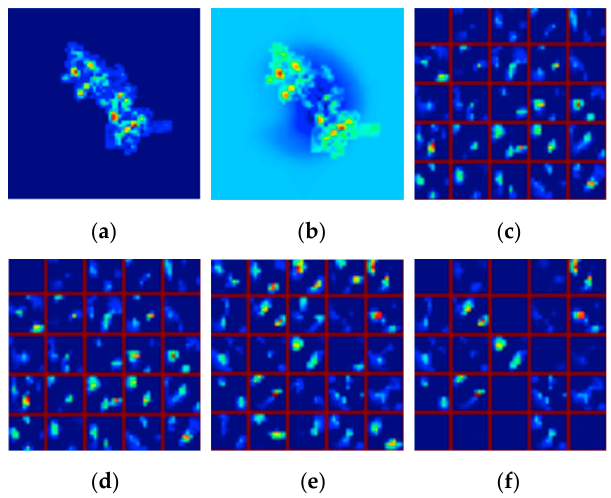
Figure 11. Feature maps of conv3 in SENet and ESENet. ( a ) input image; ( b ) input image with the mean of training samples removed; ( c ) feature maps of conv3 in the SENet; ( d ) feature maps of conv3 in the SENet after passing through the SE module; ( e ) feature maps of conv3 in the ESENet; and, ( f ) feature maps of conv3 in the ESENet after passing through the enhanced-SE module.